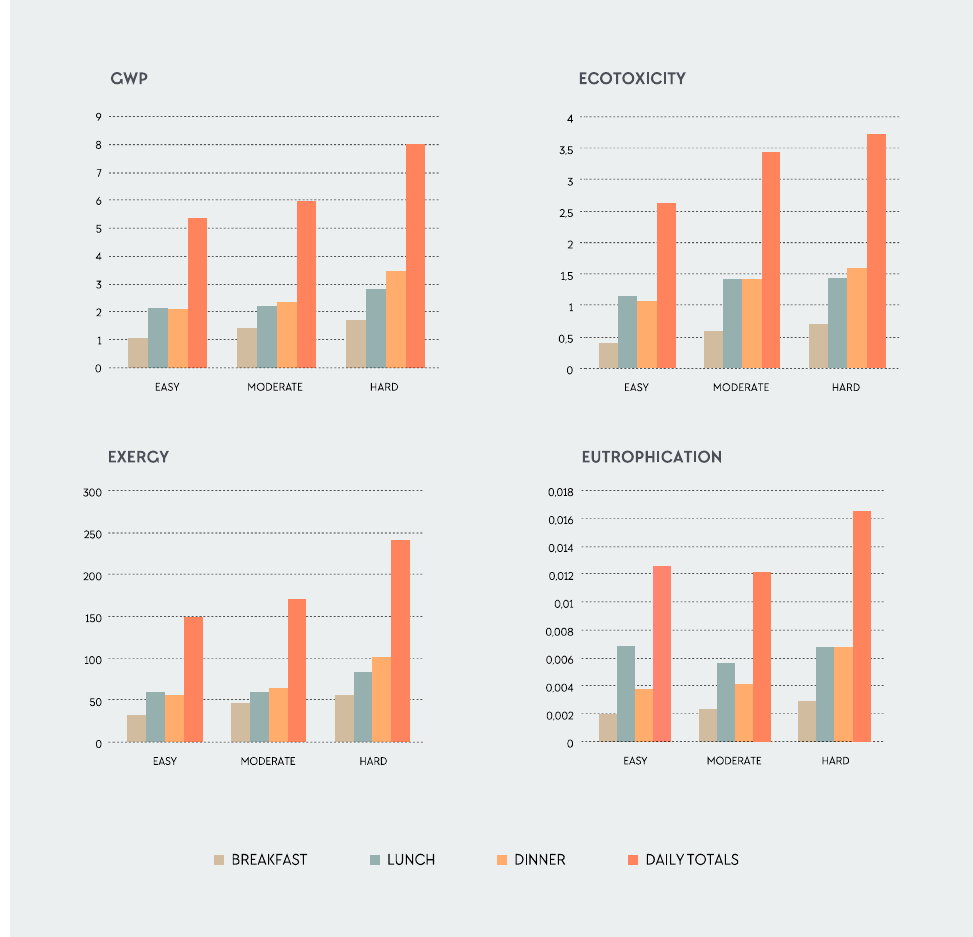
Figure 5. Meals and training load distribution of the four environmental impact categories. Values represented are per plate. Daily totals represent the sum of breakfast, lunch and dinner.